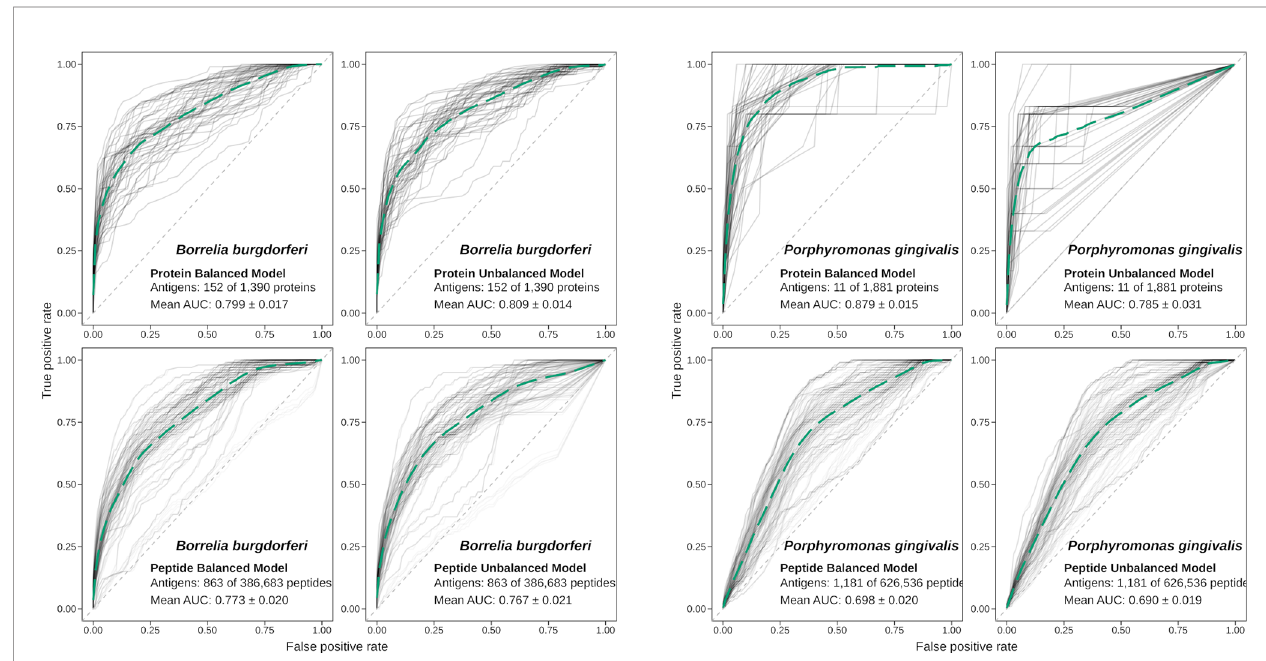
FIGURE 3 | Performance of APRANK training using balanced or unbalanced data. Performance of APRANK ’ s species-speci fi c models for B. burgdorferi and P. gingivalis . ROC curves for each iteration of training and testing are shown in light gray, and the average curves are shown in green (dashed